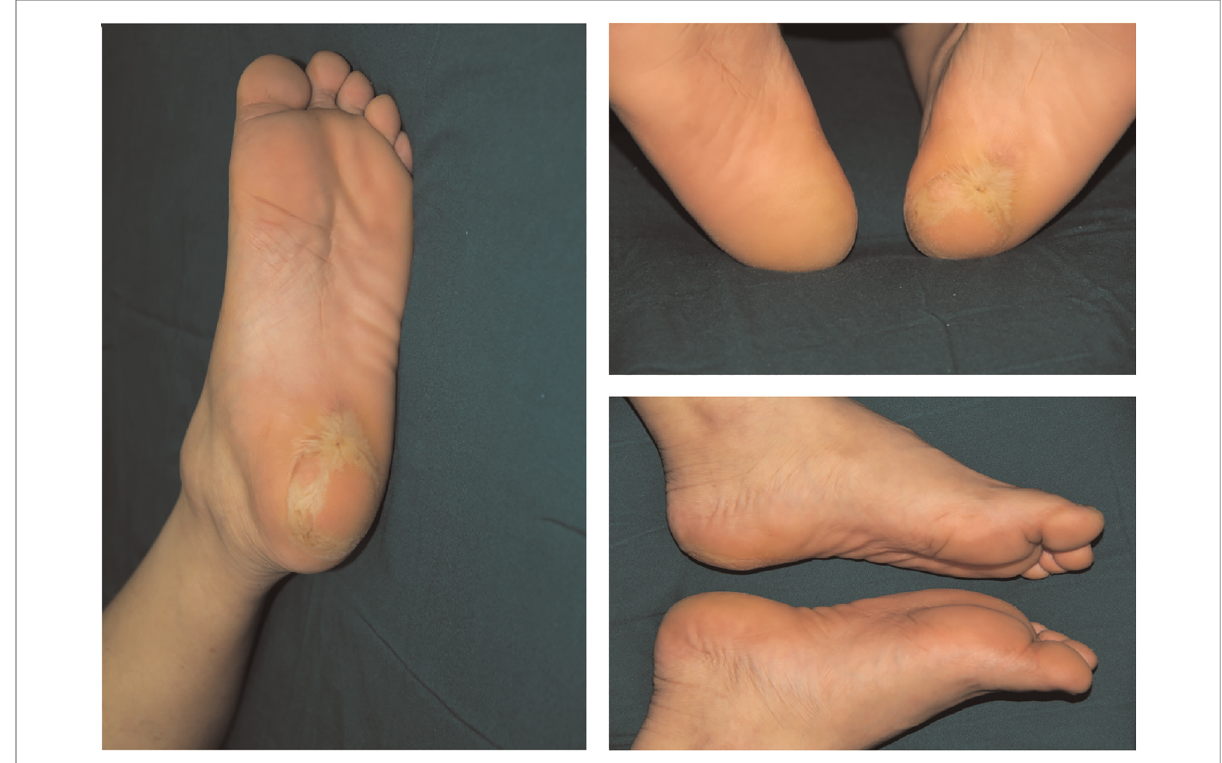
FIGURE 2 The patient demonstrated excellent aesthetic and functionality 37 months following the